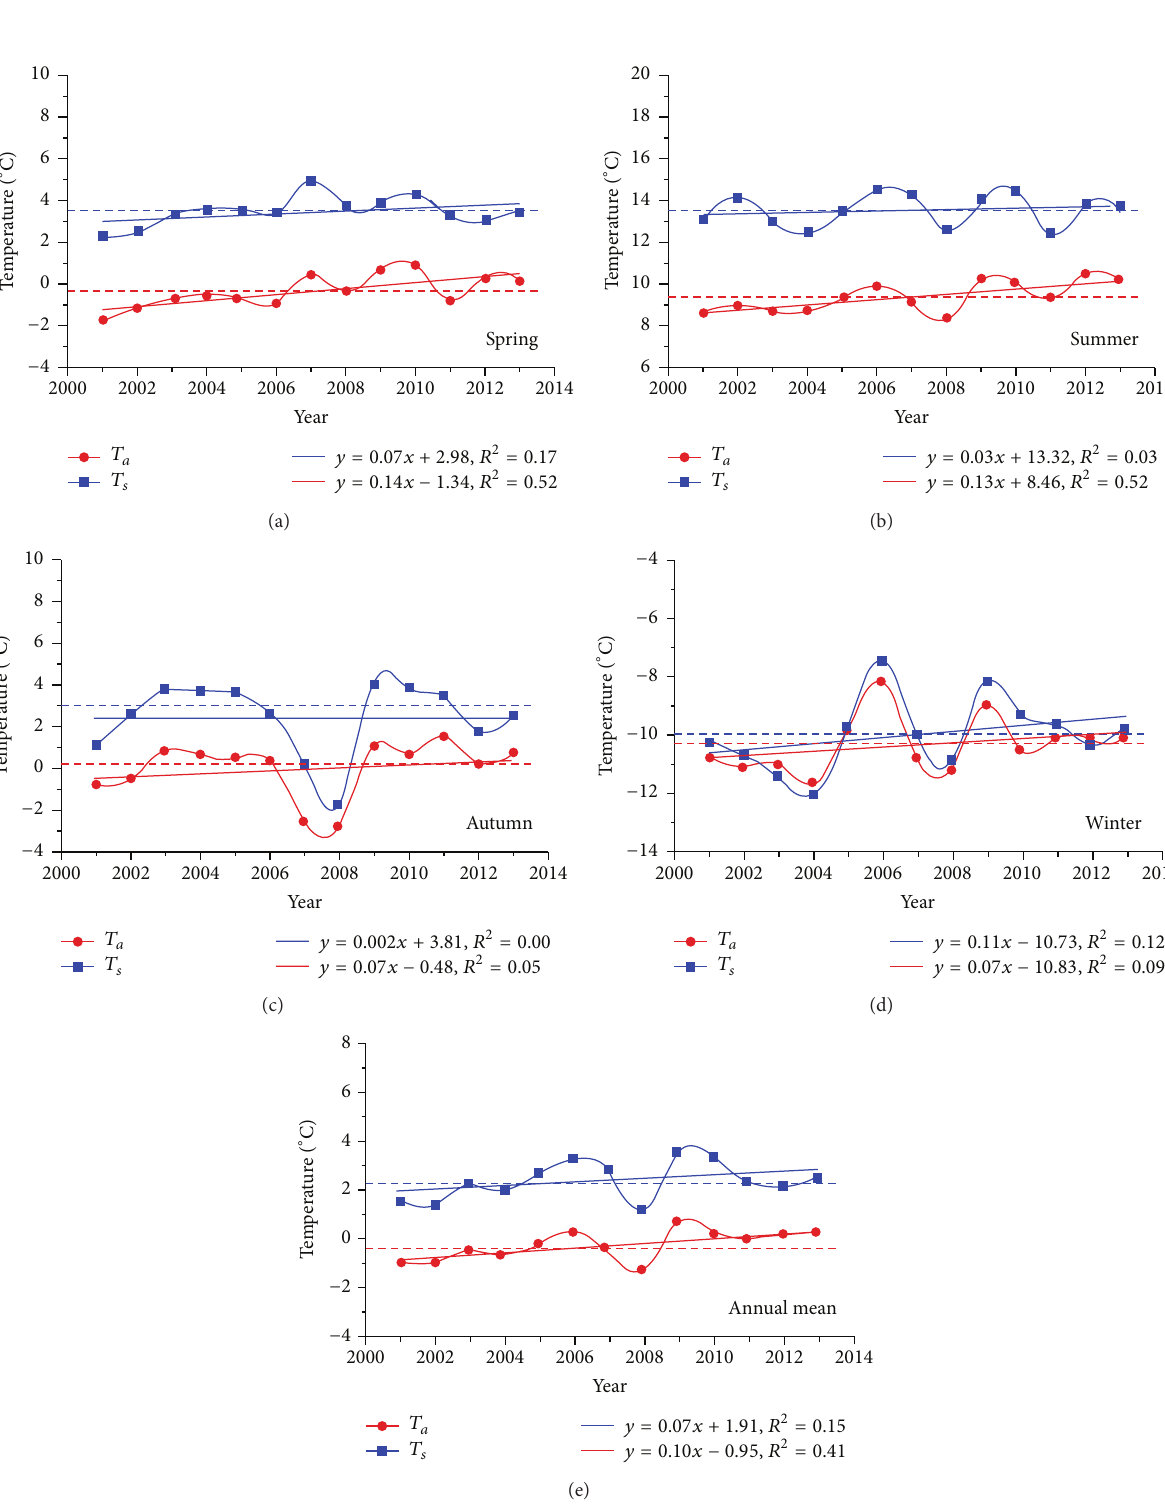
Figure 4: Averaged land surface temperature and air temperature change curves for seasons and years at BJ (curved lines are observed values, and straight lines are liner